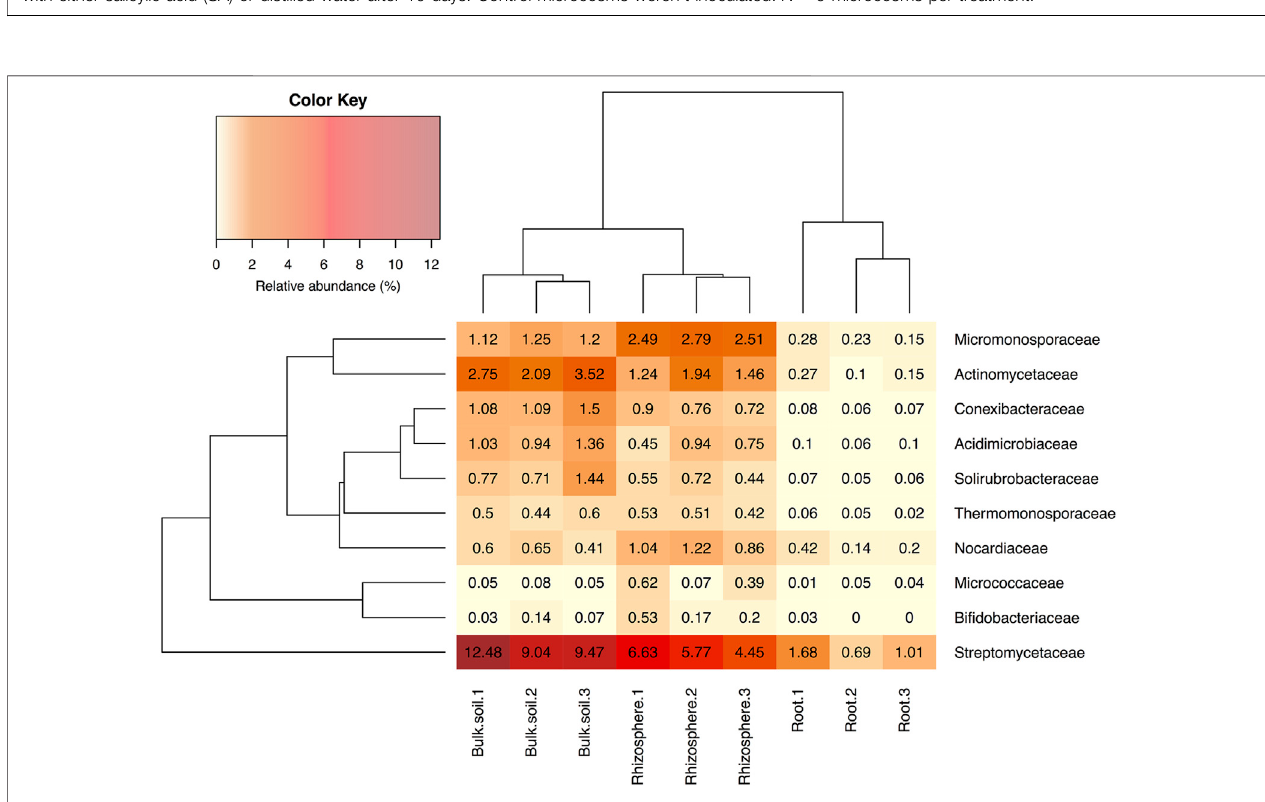
FIGURE 3 | The relative abundance of actinobacterial families in soil, rhizosphere and root compartments. N (cid:2) 3 replicate plants in individual pots. Streptomycetaceae was the most abundant family of Actinobacteria in all three compartments. Clustering represents Bray Curtis dissimilarities.